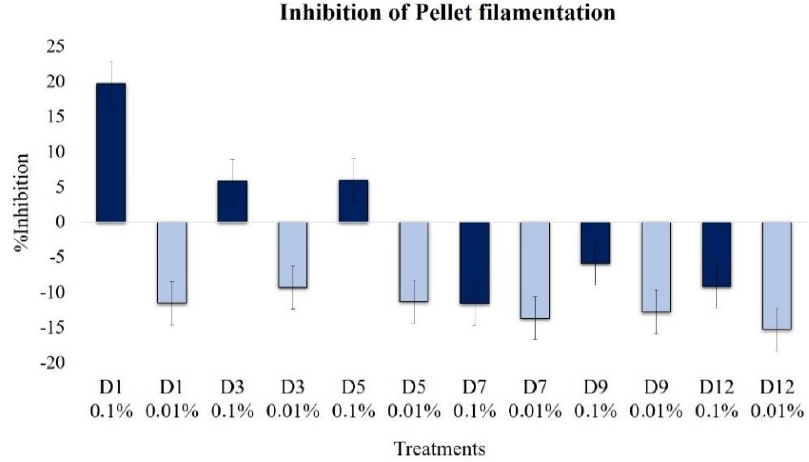
Figure 6. Effects of extracts at 0.1% (dark blue bars) and 0.01% (light blue bars) on B. cinerea pellet filamentation (1 × 10 4 conidia mL –1 , 30 h incubation, 100 rpm, 24 °C, light 12 h) .